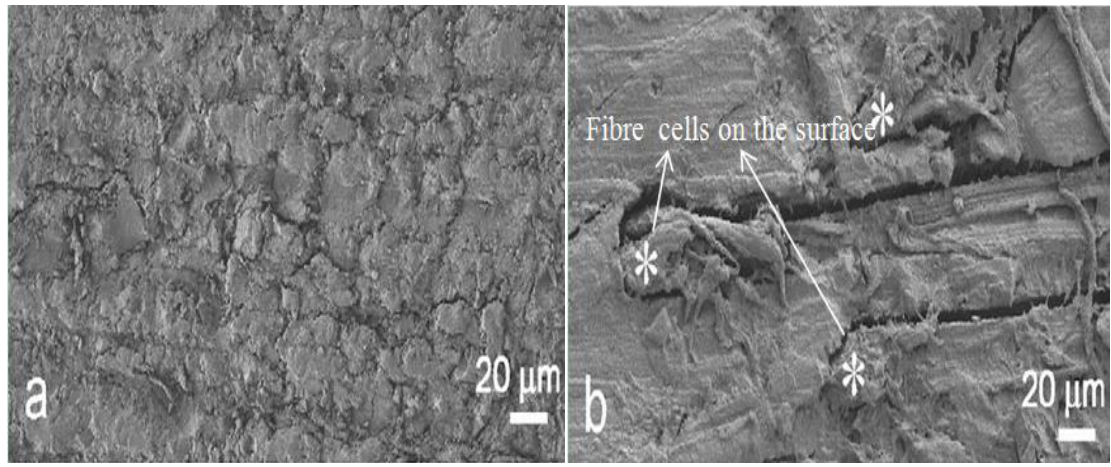
Figure 9. Scanning electron microscopy (SEM) images of flax/epoxy composites: ( a ) origin specimen; and ( b ) after eight wet-dry cycles. Adapted with permission from [84]. Copyright 2013 by